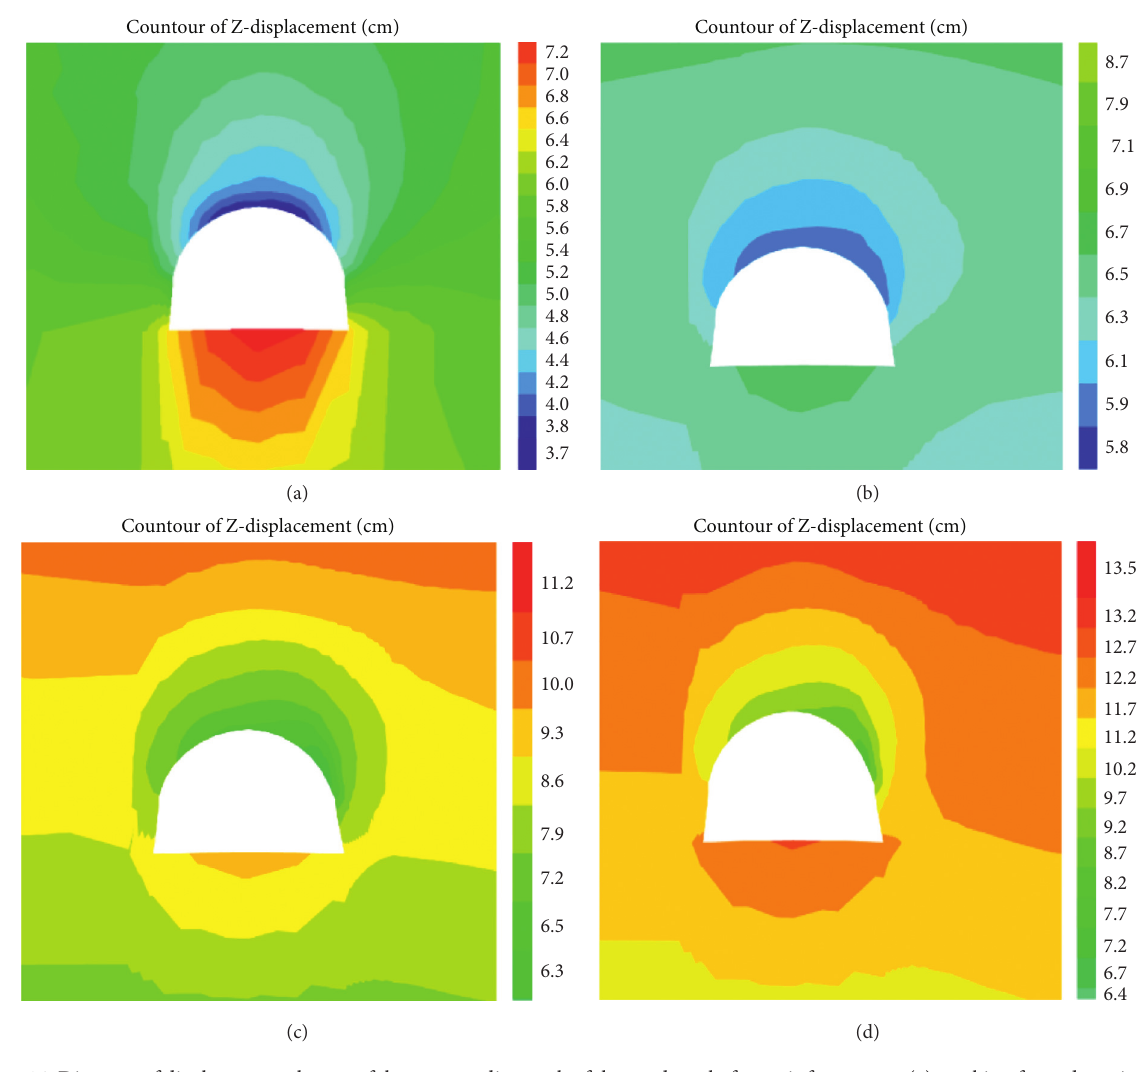
Figure 14: Diagram of displacement change of the surrounding rock of the roadway before reinforcement: (a) working face advancing 12m, (b) working face advancing 36m, (c) working face advancing 60m, and (d) working face advancing 84 m.